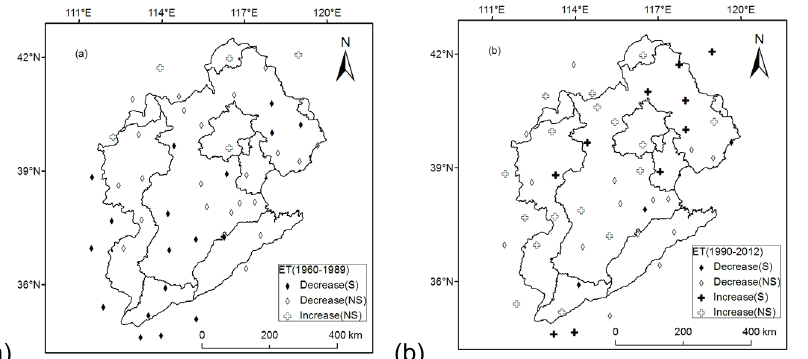
Fig. 6 Trends in annual reference evapotranspiration for the 45 stations in and around Hai River basin during (a) 1960 to 1989, and (b) 1990 to